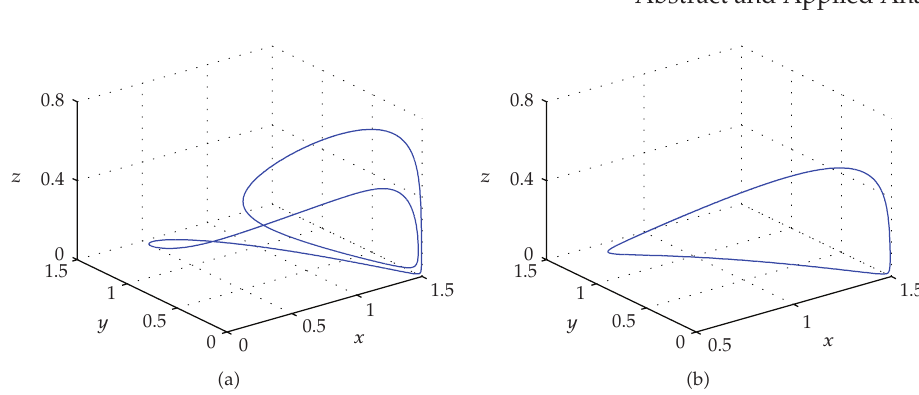
Figure 7: Period-halving bifurcation: (cid:3) a (cid:6) attractor with period-2 when d 1 (cid:7) 0 . 42; (cid:3) b (cid:6) attractor with period-1 when d 1 (cid:7) 0 . 47.